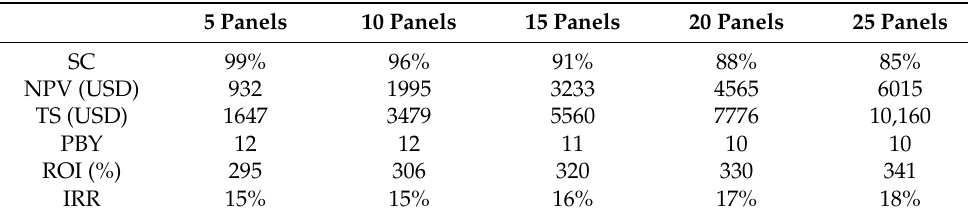
Figure 8. Economic model results demonstrate the payback time for the rooftop PV systems with a variant number of panels for house H10. Table 7. Economic model results in demonstrating the economic analysis for the rooftop PV systems with a varying number of panels for house H10.